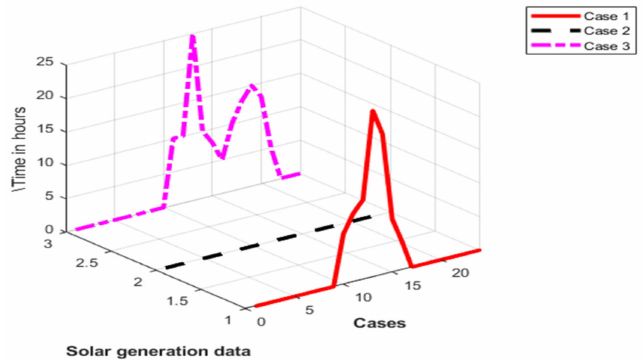
Figure 16. Solar generation data for three different cases considering uncertainties.